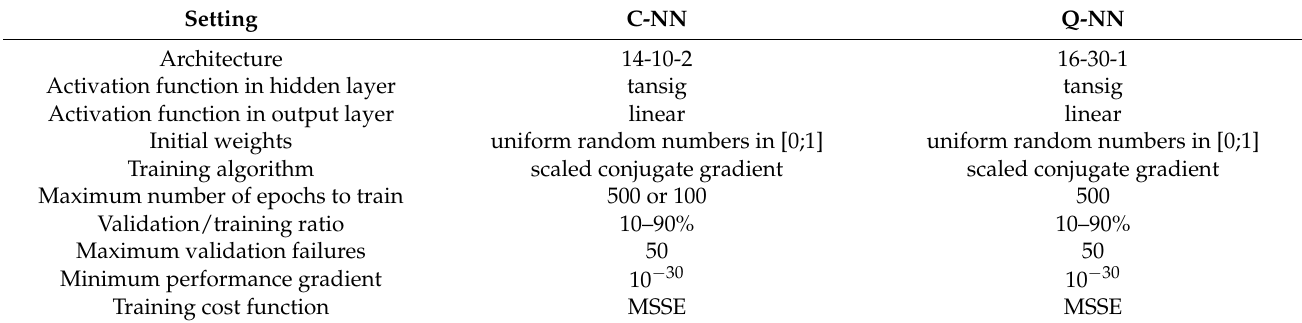
Table 3. AI-VIRL C-NN and Q-NN settings.